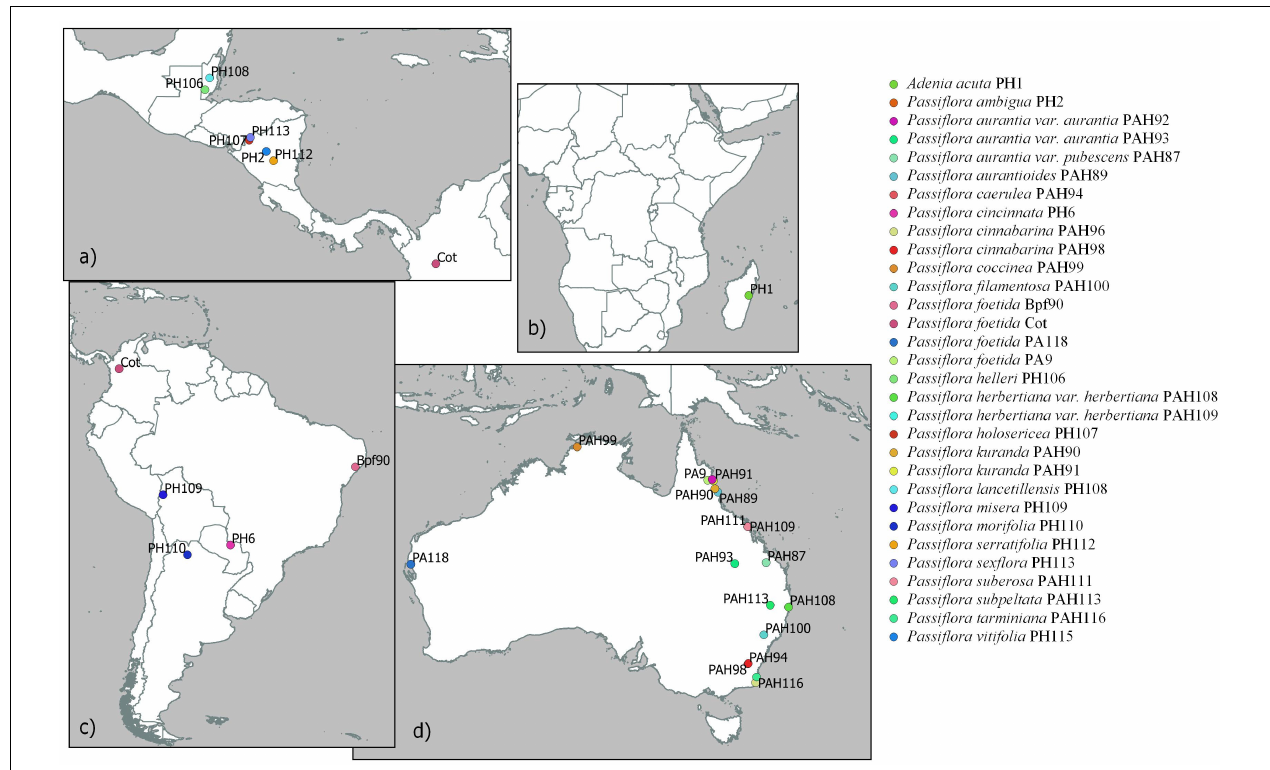
FIGURE 1 | Geographic location (when known) of non-cultivated collections of Passiflora species and Passiflora foetida sensu lato samples in the “Passifloraceae” dataset in (a) Central America, (b) Madagascar, (c) South America, and (d)